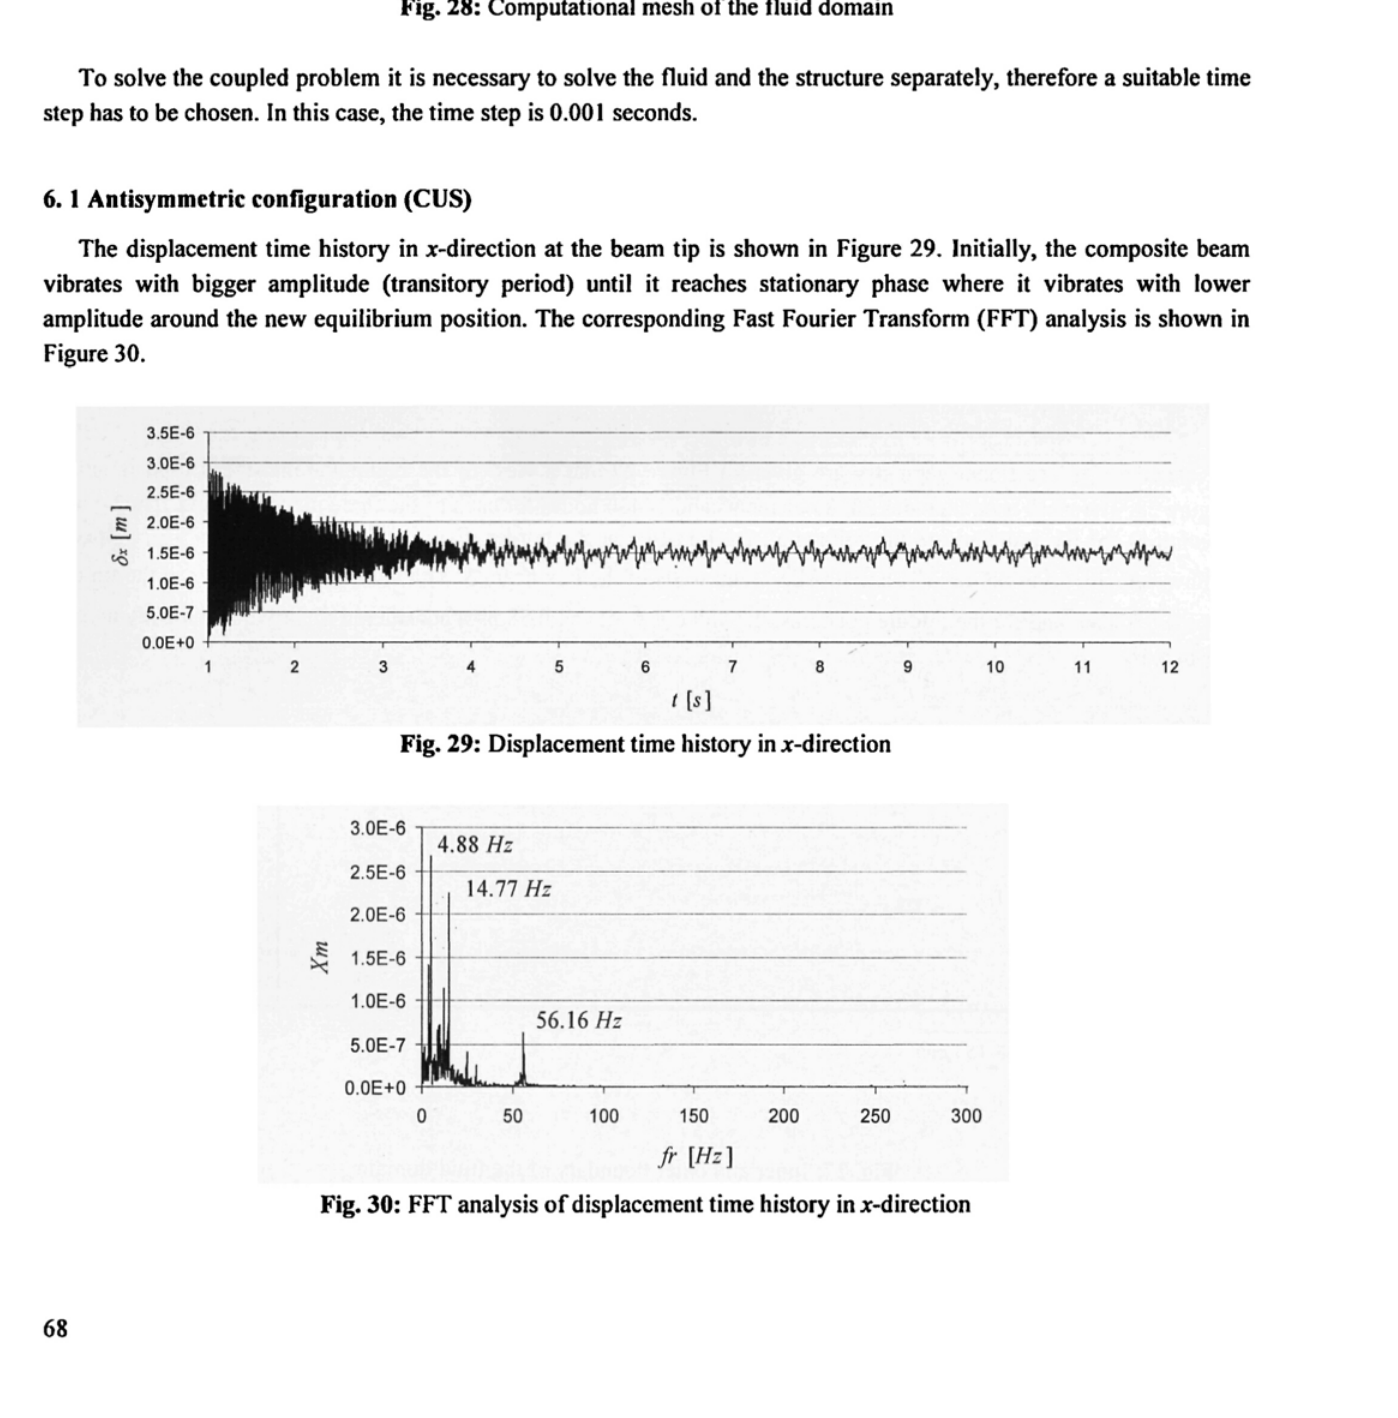
Fig. 30: FFT analysis of displacement time history in